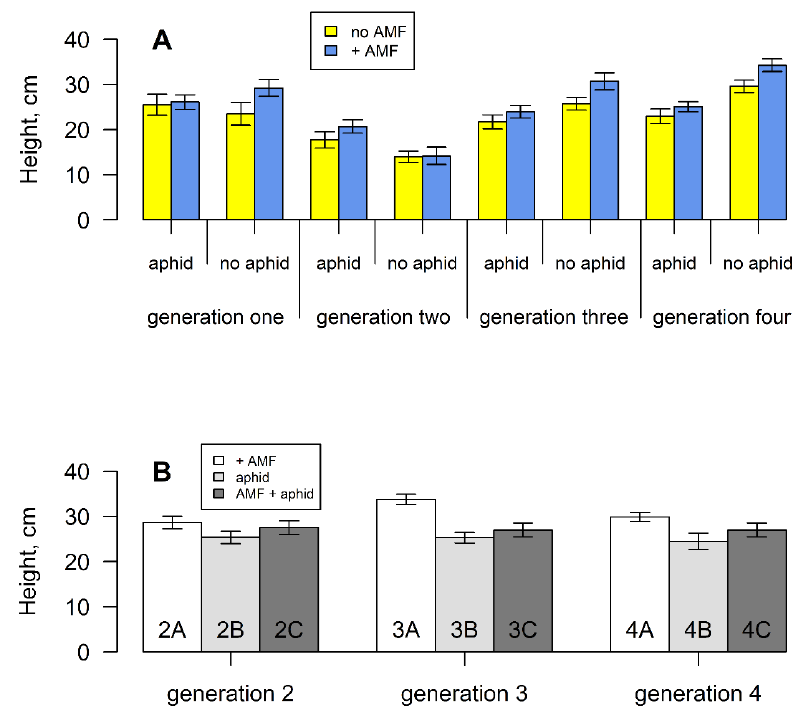
Figure 4. ( A ) Mean final plant height of S. vulgaris grown with or without arbuscular mycorrhizal fungi and aphids for four successive generations. Vertical lines represent ± one standard error. ( B ) Mean final plant height of S. vulgaris grown without AM fungi, aphids or both, from parents that experienced these treatments (2A, B and C; 3A, B and C and 4A, B and C plants in Figure S1).